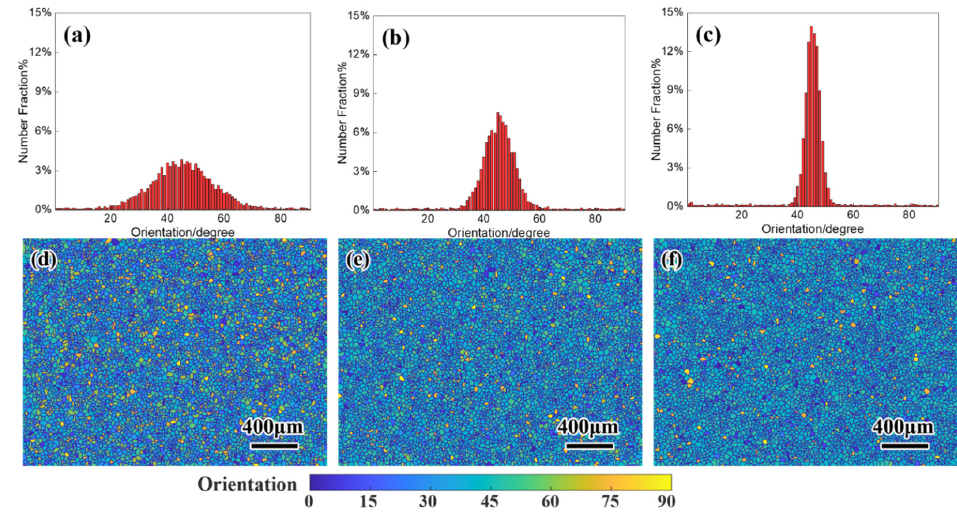
Figure 12. Initial grain structure of different texture strengths. The orientation variances of ( a – c ) were 10°, 5° and 2.5°, respectively, and ( d – f ) are the initial grain structures corresponding to ( a – c ),